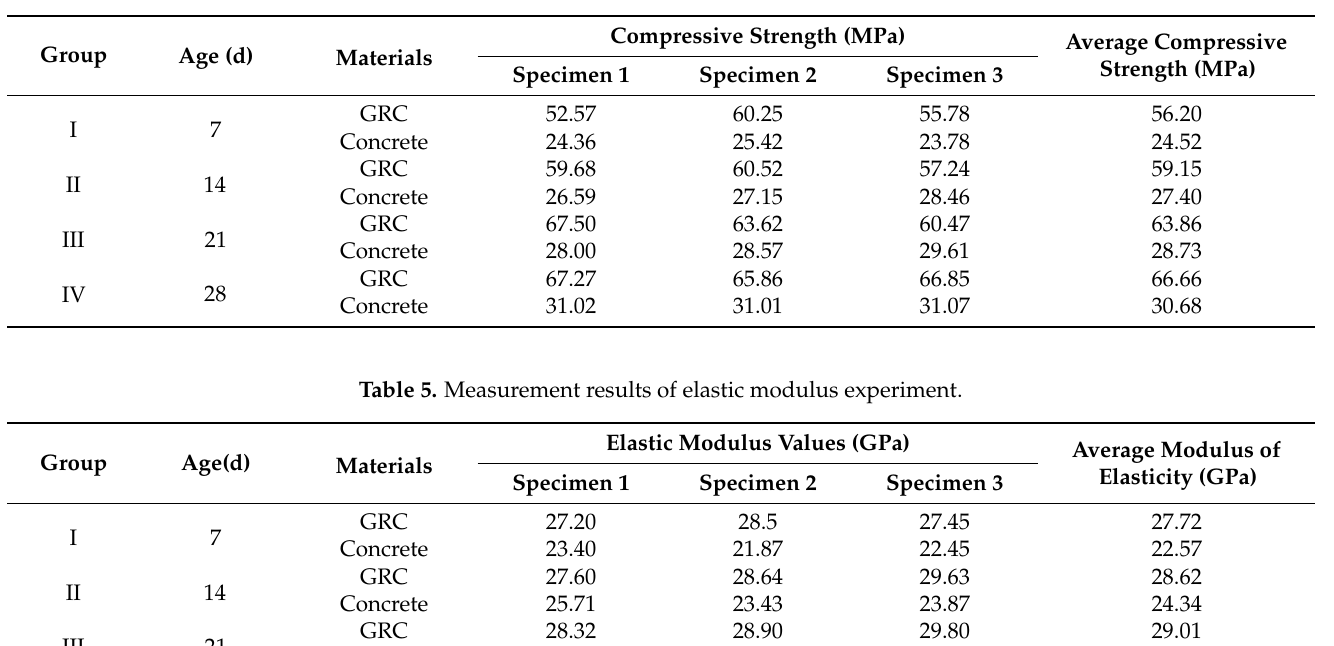
Table 4. Measurement results of compressive strength experiment.